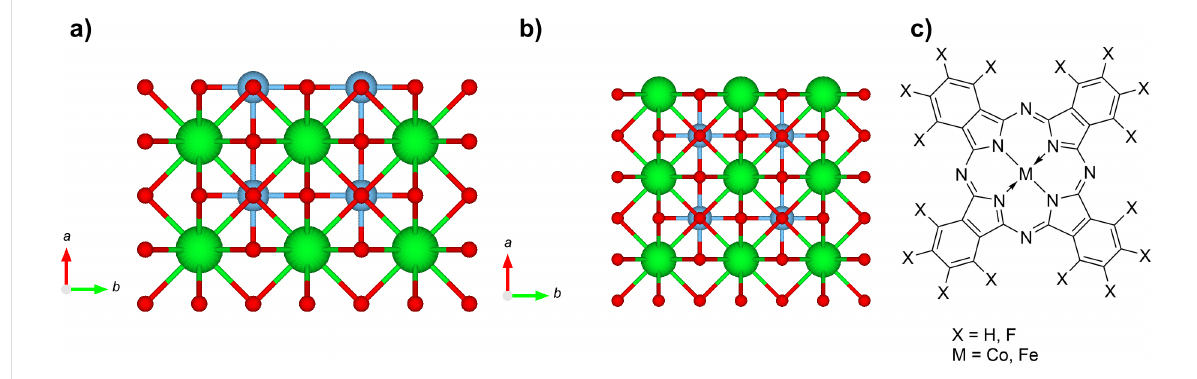
Figure 1: Bulk crystal structures (side views) of: (a) TiO 2 -terminated strontium titanate (100) and (b) SrO-terminated strontium titanate (100) (Ti 4+ : light blue, Sr 2+ : green, and O 2 − : red. The coordinate axes a , b , and c correspond, respectively, to the crystal orientations (100), (010), and (001)). (c) General chemical structure of transition metal phthalocyanines (TMPcs).